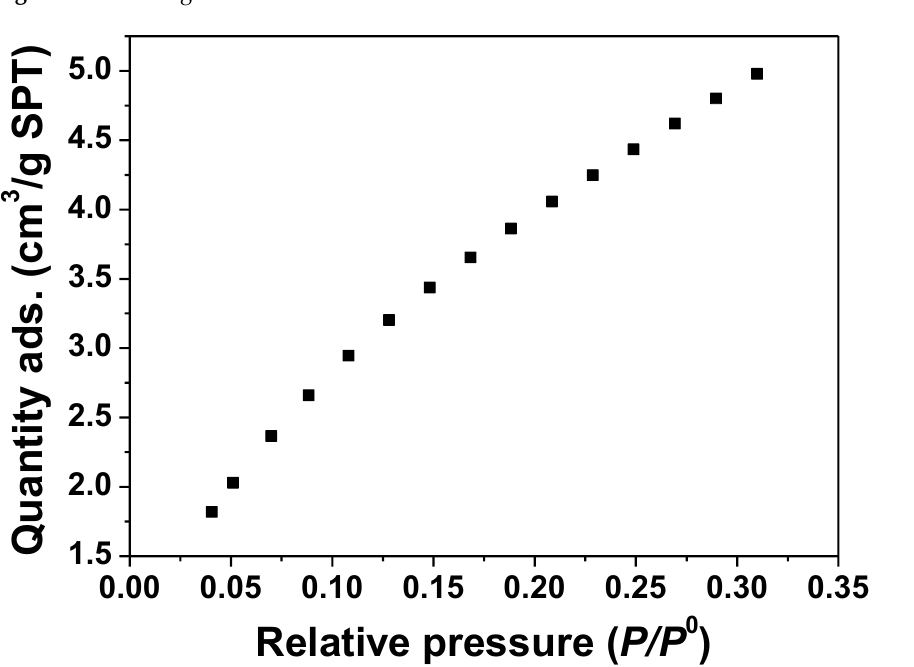
Figure 4. Adsorption isotherm. N 2 adsorption of ZnO samples, as-synthesis condition at a temperature of 180 °C.